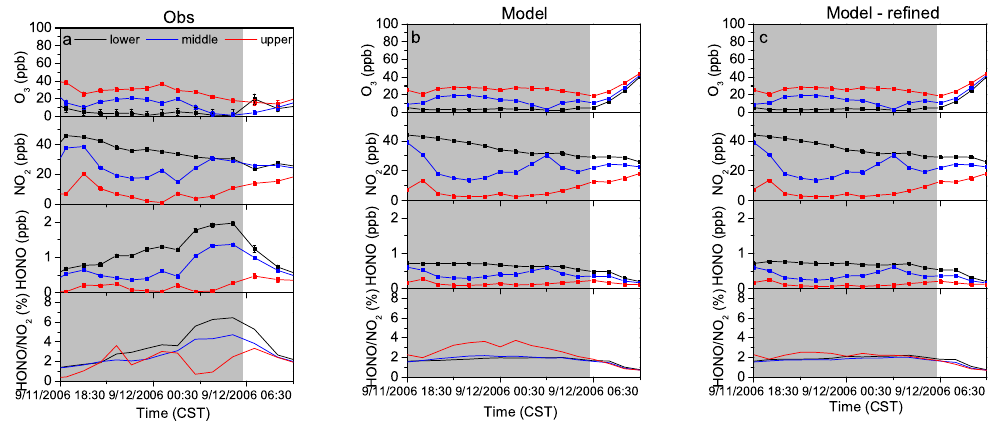
Fig. 6. Comparison of HONO, NO 2 , O 3 mixing ratios and HONO/NO 2 between observations (left) and model results (middle and right) on 11–12 September 2006. (Mixing ratios at lower, middle and upper altitudes are plotted in black, blue and red respectively.) See the Supplement for expanded version of figure.